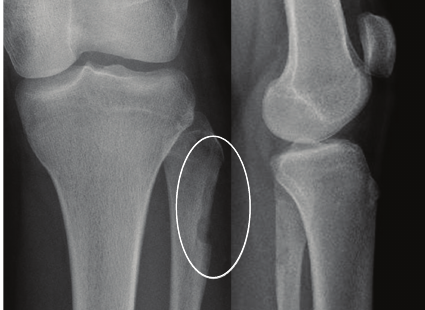
Figure 5: Postoperative radiographs demonstrate the resection zone of one-third of the shaft’s